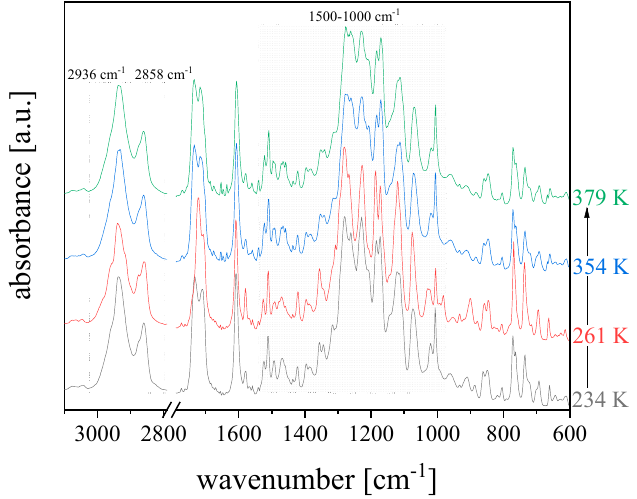
Figure 12. The FTIR spectra of 3F7HPhH7 measured during heating after fast cooling for selected temperatures at 234 K (at gSmC A * state), at 261 K (for cold crystallization), at 354 K (for Cr–SmC A * transition) and at 379 K (at SmC A * phase).